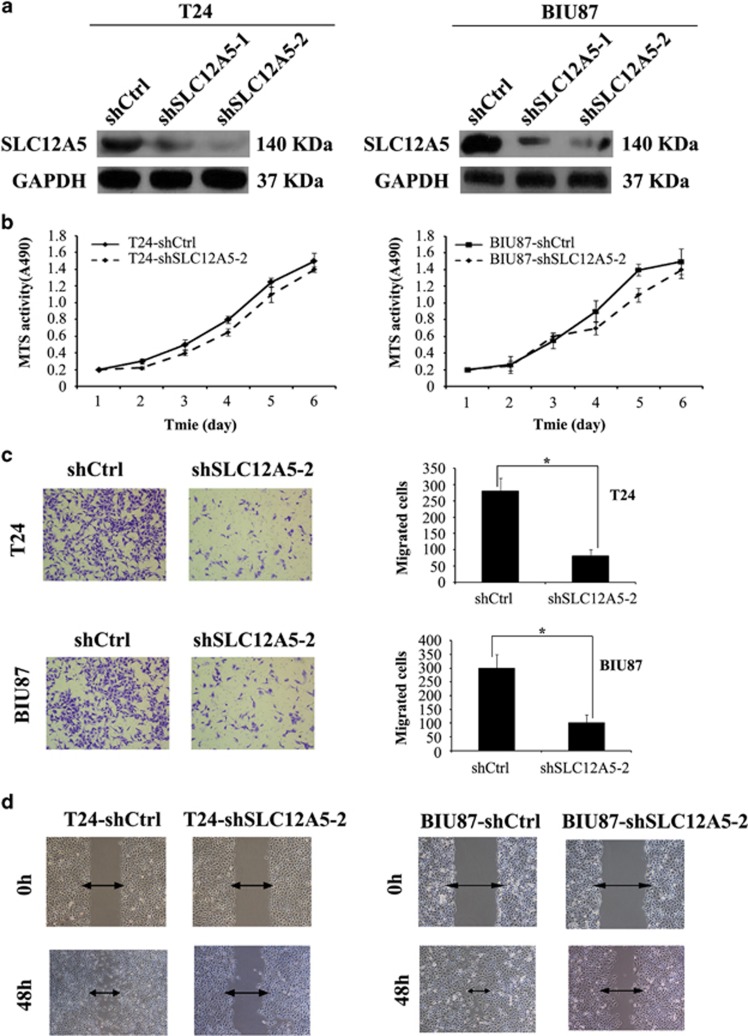
SLC12A5 enhances the migration and invasion of BUC cells in vitro and in vivo. (a) The expression of SLC12A5 was substantially decreased in SLC12A5-ShRNA BUC cells compared with that in ShCtrl BUC cells by western blot. (b) Suppression of SLC12A5 did not alter the cellular growth rate. (c) Representative micrographs and quantification of the invasiveness of SLC12A5-ShRNA BUC cells in the transwell matrix invasion assay compared with ShCtrl BUC cells. (d) Representative micrographs of the motility of SLC12A5-ShRNA BUC cells in the wound healing assay at 0 and 48 h compared with ShCtrl BUC cells. (e) Tail vein injection of BUC cells stably expressing SLC12A5 ShRNA or control shRNA into the nude mice led to metastasis to the lung. Left panel: image of a lung 2 months after tail vein injection of ShCtrl BUC cells and SLC12A5-ShRNA BUC cells. Right panel: number of metastases in lungs of mice (n=6 per group) 2 months after tail vein injection of ShCtrl BUC cells (mean±S.E.M., 16.0±5.5 for T24-ShCtrl cells; 15.3±6.7 for BIU-ShCtrl cells) and SLC12A5-ShRNA BUC cells (mean±S.E.M., 3.8±4.0 for T24-SLC12A5-ShRNA cells; 3.8±3.1 for BIU87-SLC12A5-ShRNA cells). The nodules were examined under an anatomical microscope; *P<0.01